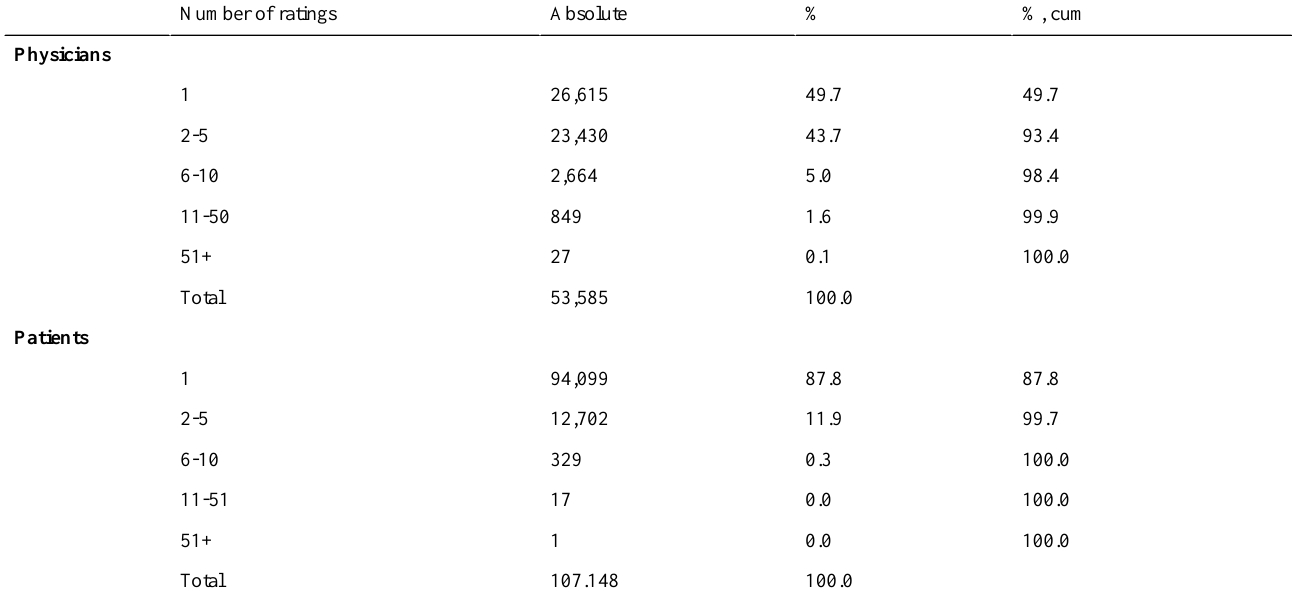
Table 2. Number and distribution of ratings on jameda (physicians and patients).